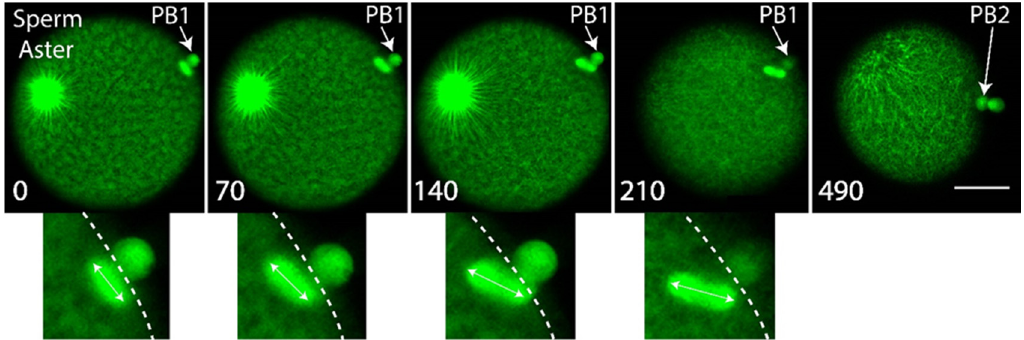
Figure 4. Second meiotic spindle rotates during PB2 emission. Eggs were previously microinjected with mRNA encoding Ens::3GFP to label the microtubules (green). Confocal images extracted from a time-lapse experiment showing the rotation of the second meiotic spindle. Upper row of images showing that the second meiotic spindle lies under PB1 parallel to the cortical surface, then begins to rotate (image 2) and continues to rotate (images 3 and 4) as PB2 is emitted (see last image of Figure and of Supplementary Movie S6). The meiotic spindle rotates 50°+/ − 3°, n = 13, mean +/ − sem. Insets at the bottom show more clearly the rotation of the second meiotic spindle (double headed arrow shows spindle orientation). Large sperm aster is also visible. n = 13. Scale bar = 40 µm. Time between images is indicated in seconds on each image. See Supplementary Movie S6.